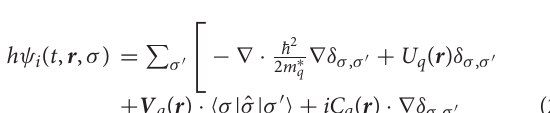
TABLE 1 | Parameter setting in the